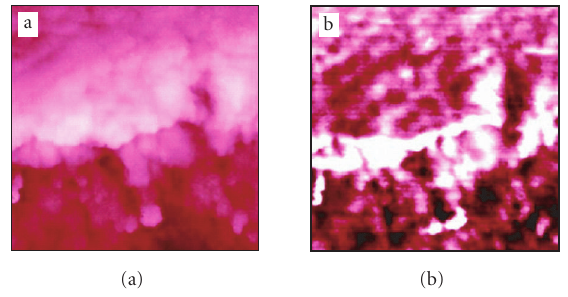
Figure 25: Microtome ruptures at the enamel-dentin boundary as determined by (a) shear-force AFM (10 μ m, Z range 1 μ m) and (b) apertureless